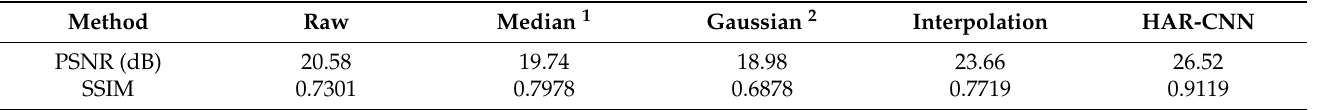
Table 1. Image restoration performance of various algorithms for honeycomb-pattern synthesized